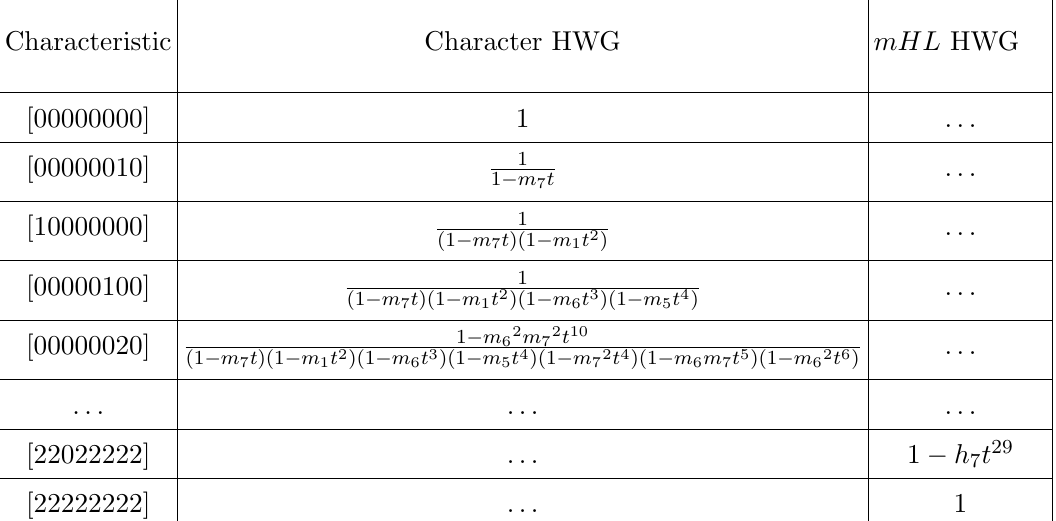
Table 31 . E 8 orbits and HWGs. An mHL HWG of 1 denotes mHL E 8 centre of the Hasse diagram are